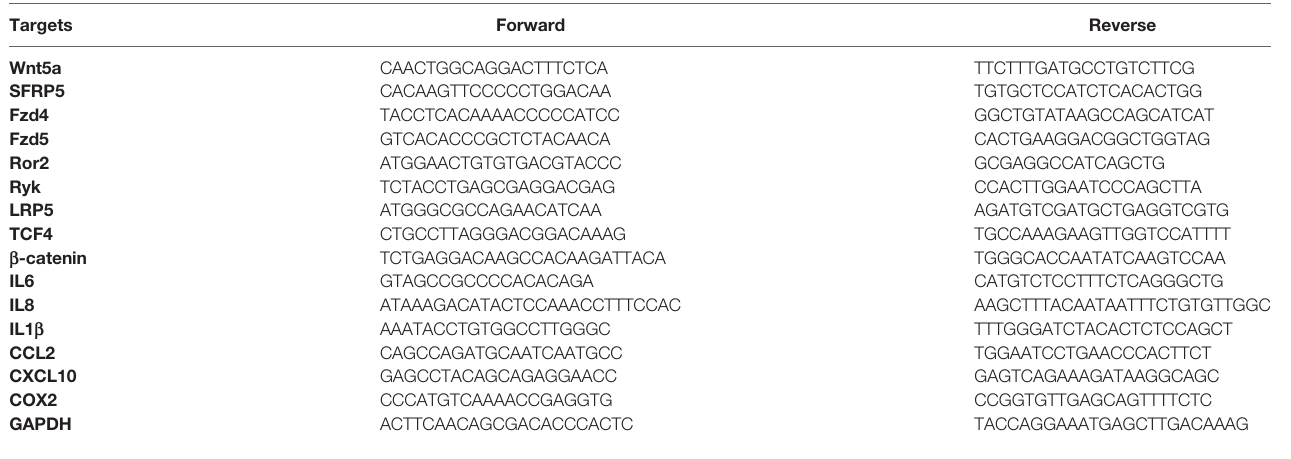
TABLE 2 | Primers (Invitrogen ® ) used for qPCR.